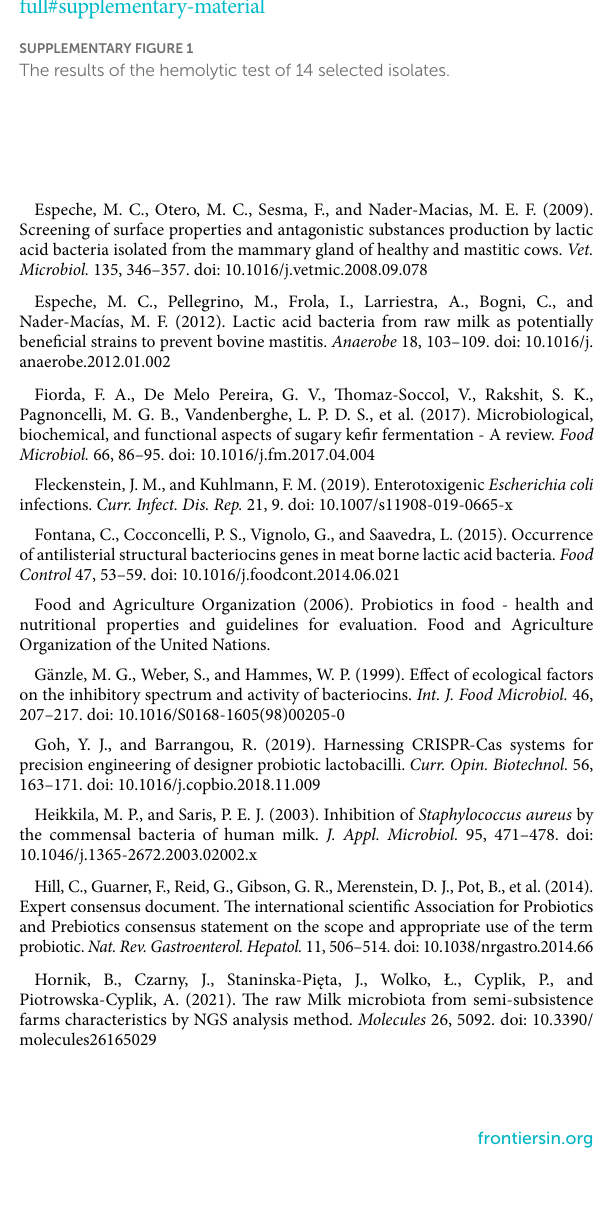
SUPPLEMENTARY FIGURE 1 The results of the hemolytic test of 14 selected